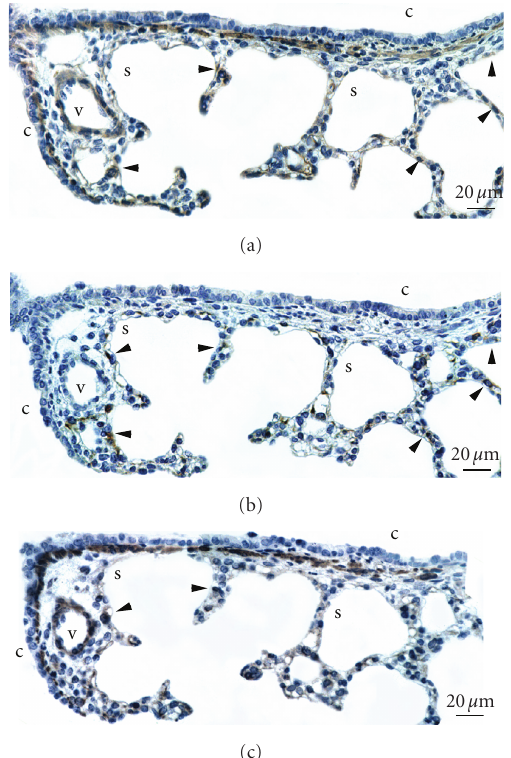
Figure 3: Rat lungs. Postnatal day 3. Methacarn fixation. Immunolocalisation of di ff erent markers, carried out in adjacent sections. Standard ABC method. Haematoxylin counterstaining. s: saccule; c: canalicular portion of respiratory space; v: vessel. Bar 20 μ m. (a) α -SMA immunolocalisation. Besides what found in the vascular wall, a strong labelling is found in the myocytes adhering to the epithelium in the canalicular portions of respiratory spaces, as well as in cells located in the intersaccular walls. (b) PDE5 immunolocalisation. The labelling is restricted to the cytoplasm of several stromal cells, located in close proximity with the saccular boundary. The myocytes of the small vessel and of respiratory channels are unstained. (c) desmin immunolocalisation. Both the myocytes in the canalicular portions of respiratory spaces and those belonging to the vessel wall are strongly labelled; moreover few labelled cells are scattered in the intersaccular walls. Arrows indicate some α -SMA- or desmin-containing PDE5-positive